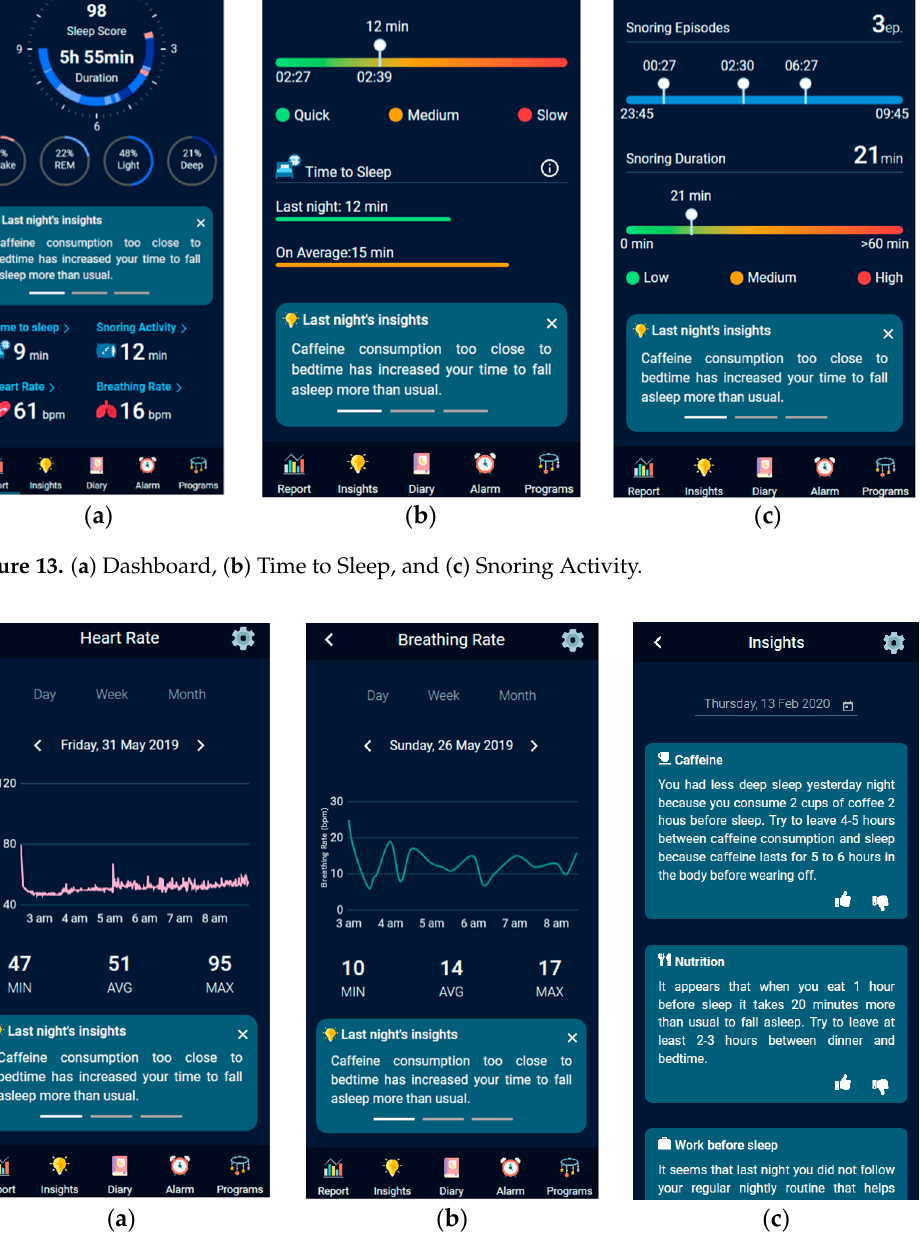
Figure 14. ( a ) Heart rate, ( b ) Breathing Rate, and ( c ) Insights.